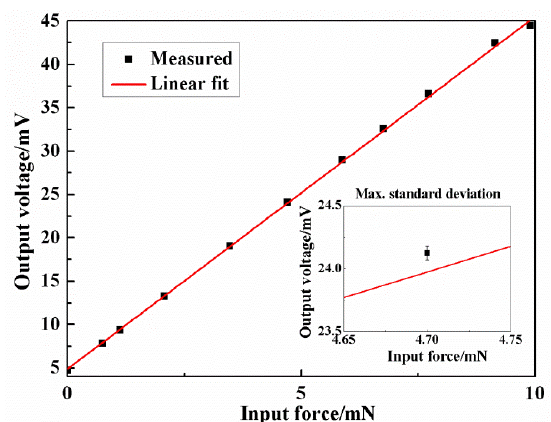
Figure 12. The calibration results.